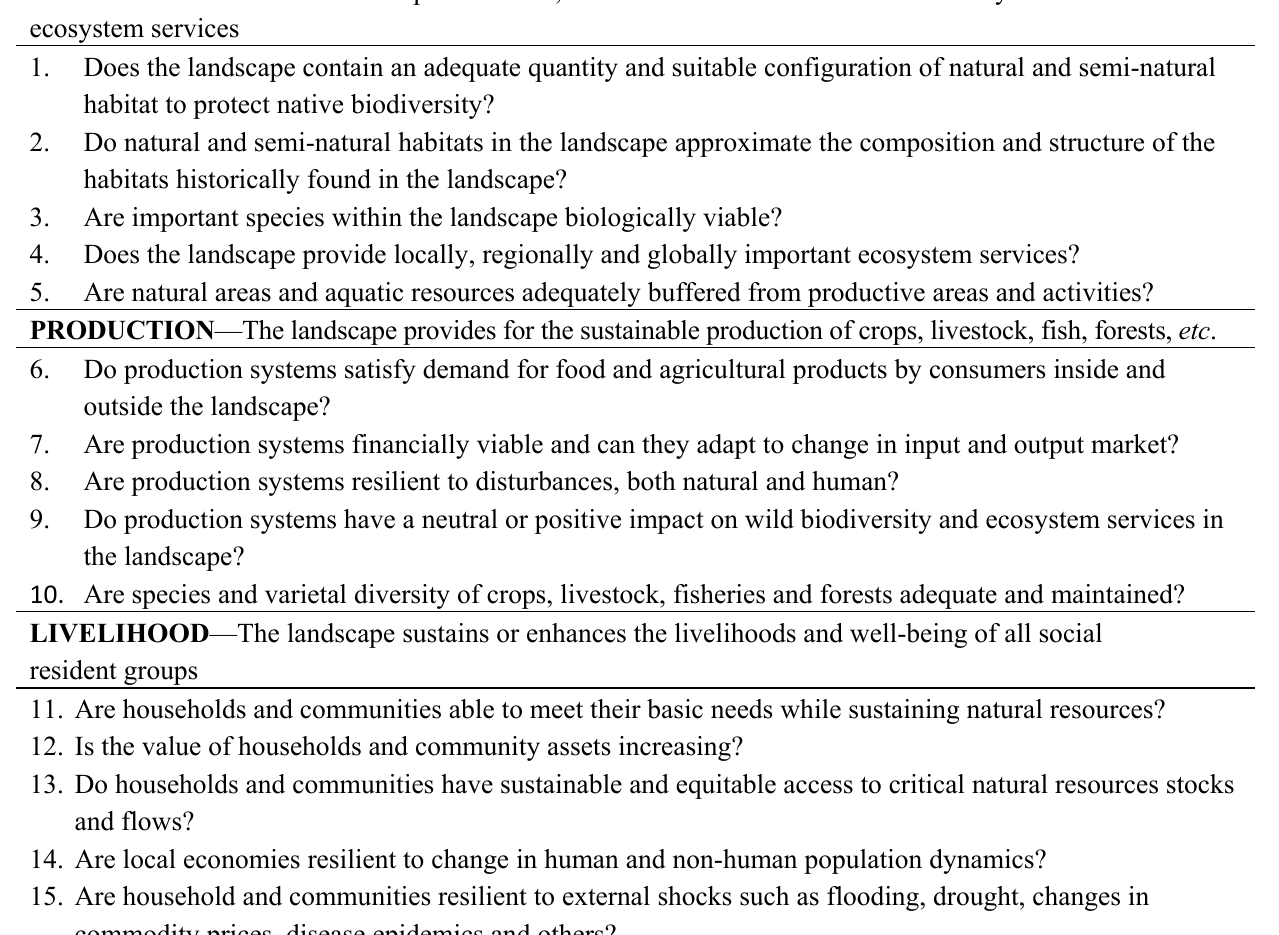
Table 1. Detailed framework of the Ecoagriculture Landscape Performance (ELP) sub-index: ecoagriculture goals and criteria